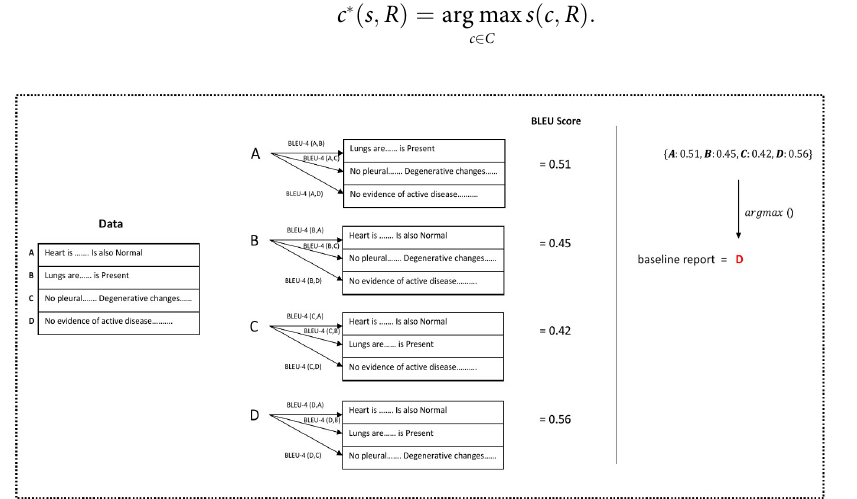
Fig 3. Illustration of unconditioned Baseline 1, which optimizes the BLEU-4 score.